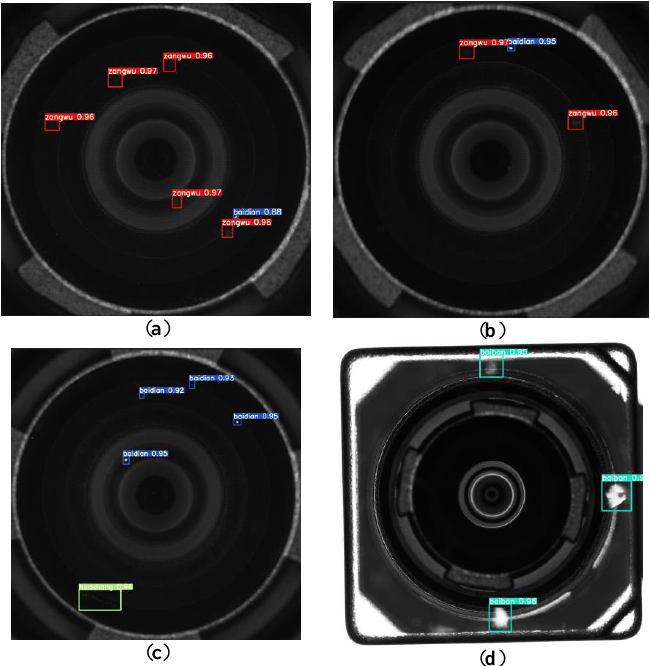
Figure 17. Examples of detection test results for different types of defects. ( a ) Dirt + white dots. ( b ) Dirt + white dots. ( c ) White dots + scratch. ( d ) White spots.